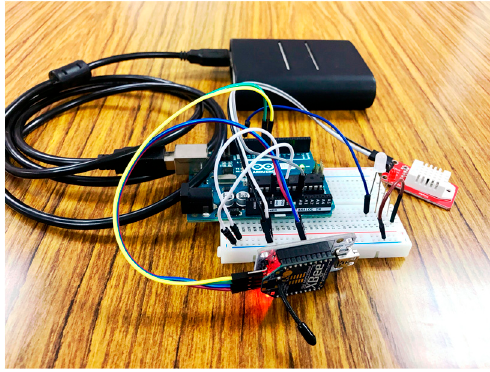
Figure 11. The indoor monitoring device.